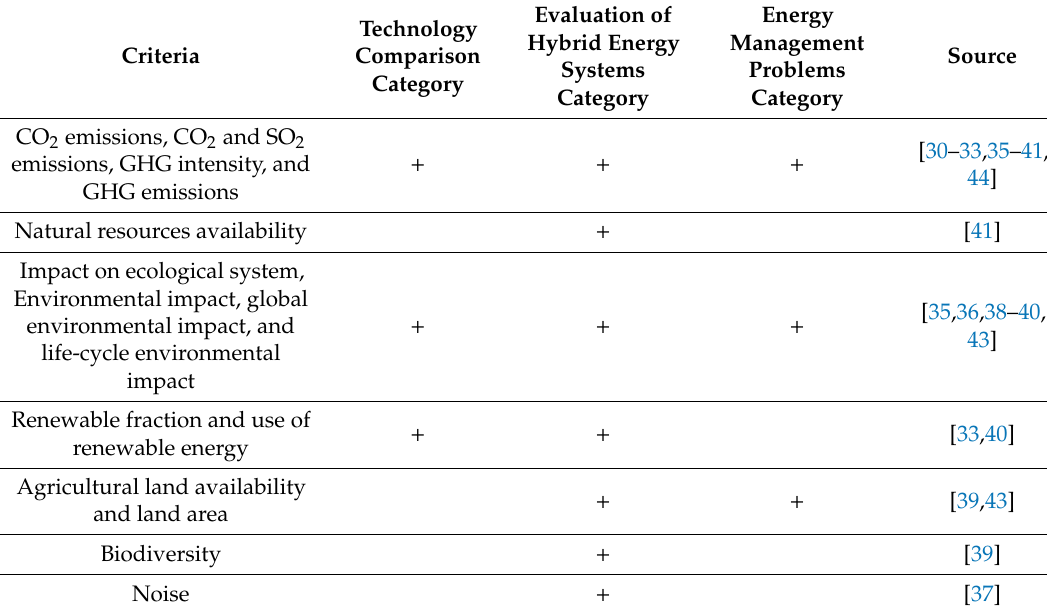
Table 8. The overview of environmental